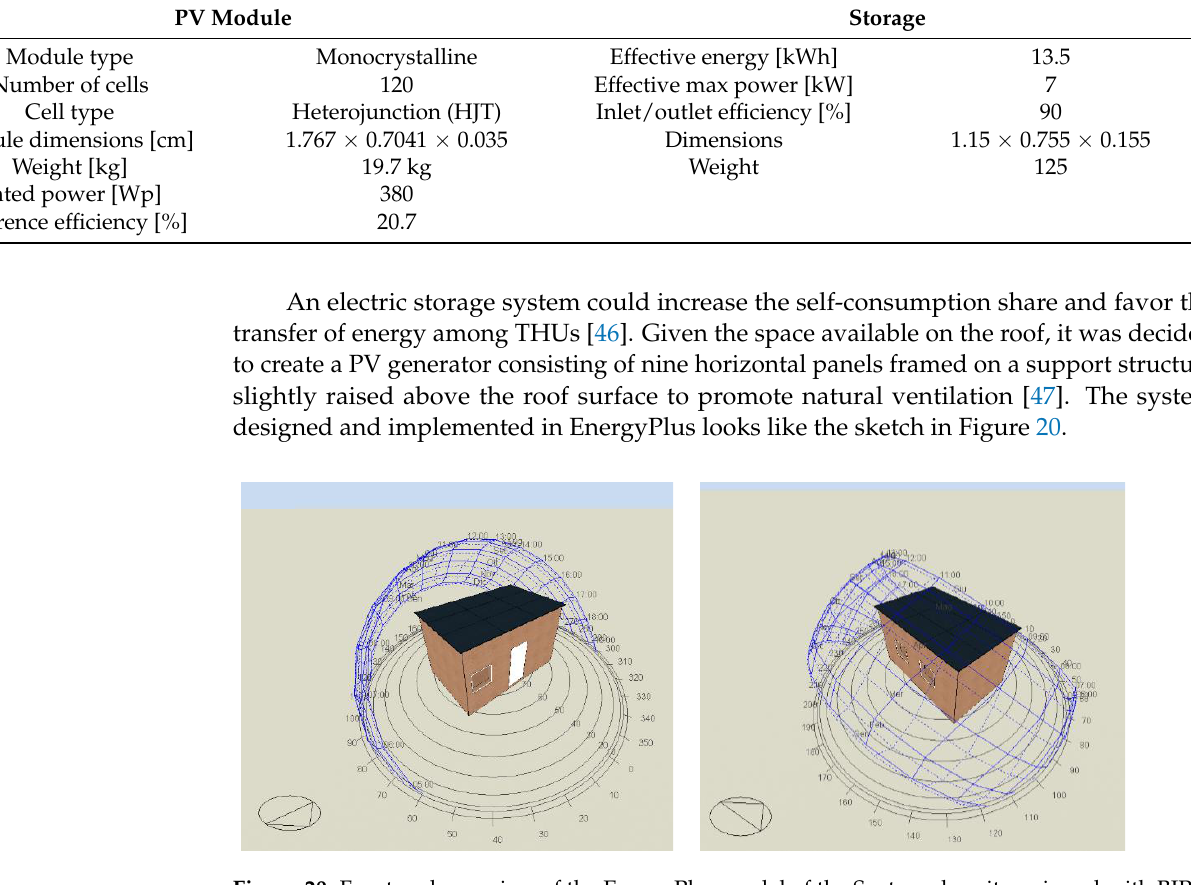
Figure 20. Front and rear view of the EnergyPlus model of the Sustanzeb unit equipped with BIPV. Table 9. Technical characteristics of the PV module and the storage system.